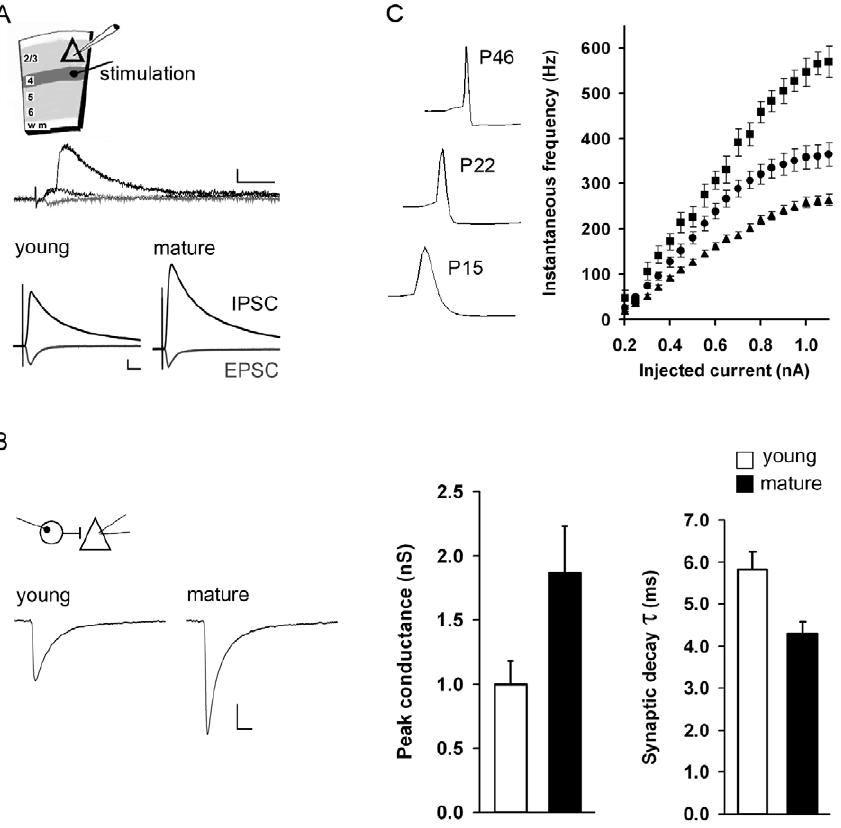
Figure 2. Maturation of GABAergic synaptic and intrinsic properties in primary visual cortex. (A) Stimulus recording configuration for determining the maximal IPSC amplitude prior to (young) and during (mature) the critical period. Upper trace, example of disynaptic IPSC activity in a layer 2/3 pyramidal neuron in response to stimulation of layer 4, 15 m A intensity. IPSC responses are from two separate trials (black), EPSC (gray); scale bar: 50 pA, 10 ms. Lower traces, amplitude of isolated monosynaptic AMPA-mediated current (EPSC, recorded at the empirically determined GABA A reversal potential, gray) and compound GABA A -mediated current which included both monosynaptic and polysynaptic IPSCs (recorded at 0 mV, black) in layer 2/3 pyramidal neurons in response to stimulation of layer 4. Stimulus input- output curves for a range of stimulation intensities (10– 80 m A) were generated (see Figure S1). The average current from all trials in which a 350 6 50 pA EPSC was elicited is shown here. Young: n=9 (of 14 cells) fulfilled this criteria, mature: n=8 (of 13 cell) fulfilled this criteria. The normalized IPSC charge (nA*ms) shown here increased 1.7-fold with age (young, 36.5 + / 2 3.6; mature, 62.0 + / 2 9.8 pC, t-test p , 0.05). GABA B and NMDA-mediated currents were blocked. Scale bar: 250 pA, 10 ms. (B) Unitary IPSCs recorded in layer 2/3 pyramidal neurons in response to stimulation of single Pv + basket interneurons prior to the critical period (n=14), and during the critical period (n=19). Left, averaged current responses across all cells. The average IPSC amplitude increased 1.8-fold with age, while the average synaptic decay time-constant decreased roughly 25%, from 5.8 to 4.3 ms. See Table 1 for statistics. (C) Input/output curves of